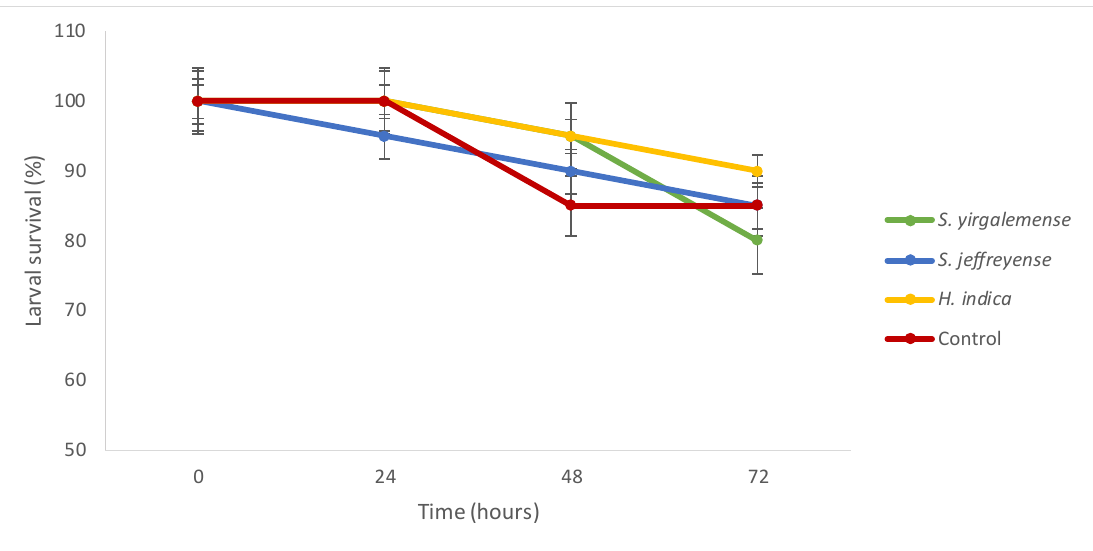
Figure 1. Percentage of Cacosceles newmannii larvae surviving infection by the three nematodes species, for both trials combined. Data is shown with standard errors of the mean (SEM).